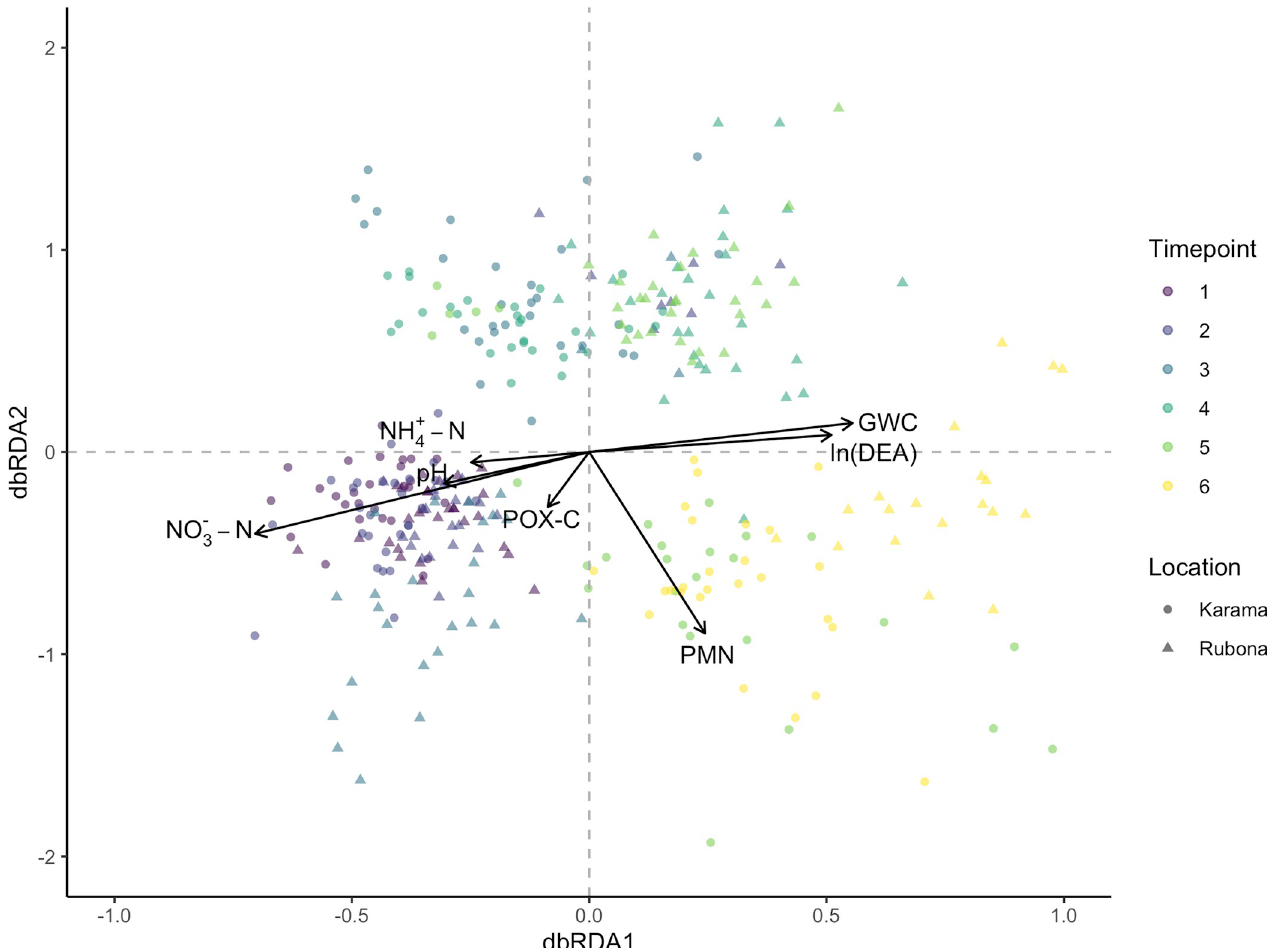
Fig 3. Distance-based redundancy analysis of gene co-occurrences constrained by soil properties (0–12 cm) at two locations in Rwanda across 6 sampling periods. A Spearman’s dissimilarity matrix was used as the response factor. A forward selection procedure identified the most parsimonious set of explanatory variables to retain in the model. Vectors represent soil properties retained in the model, with vector length corresponding to explanatory power. Axes 1 and 2 explained 29.4% and 7.4% of the observed variation, respectively. The full model explained 38.2% of observed variation in gene co-occurrences (P < 0.001).